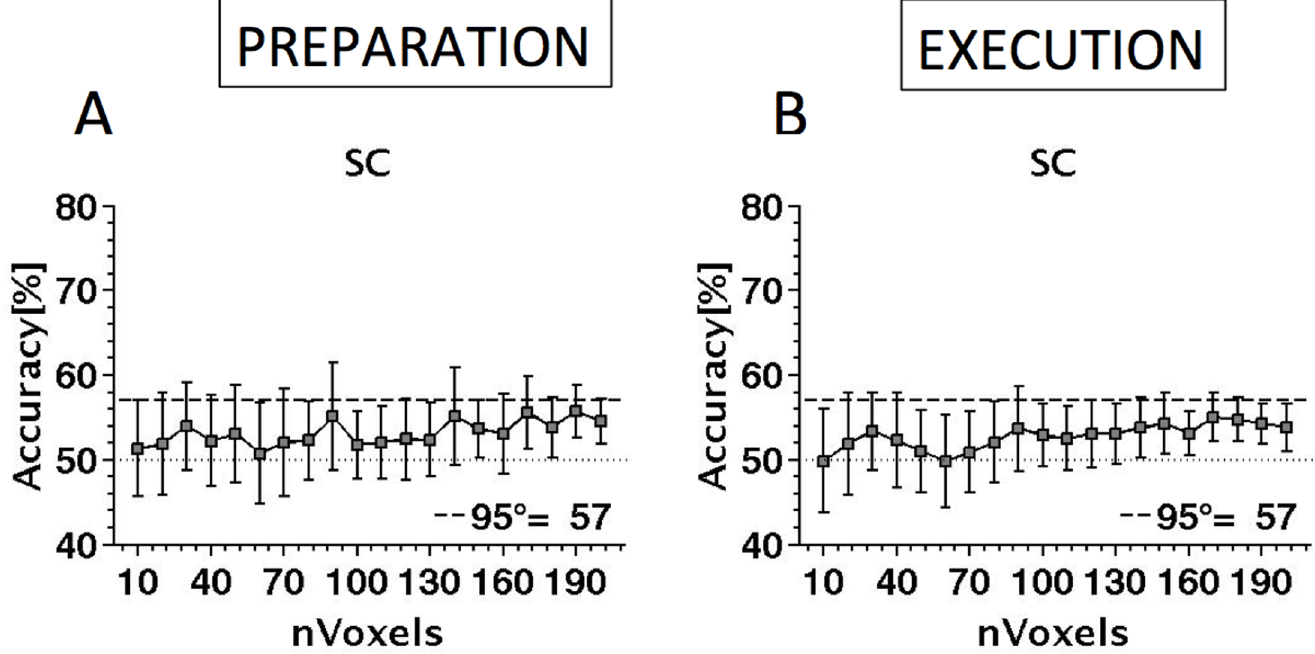
Fig 10. Decoding performance in the SC shown as a function of voxel sample size (number of exemplars) included in the MVPA analysis. Performance for distinguishing anti-saccade from pro-saccade is shown for the preparation phase (A) and the execution phase (B). Key as for Fig 5.